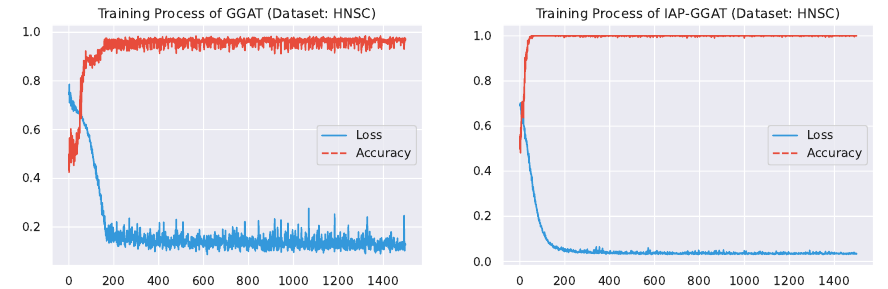
Figure 8. Training process of GGAT and IAP-GGAT on HNSC